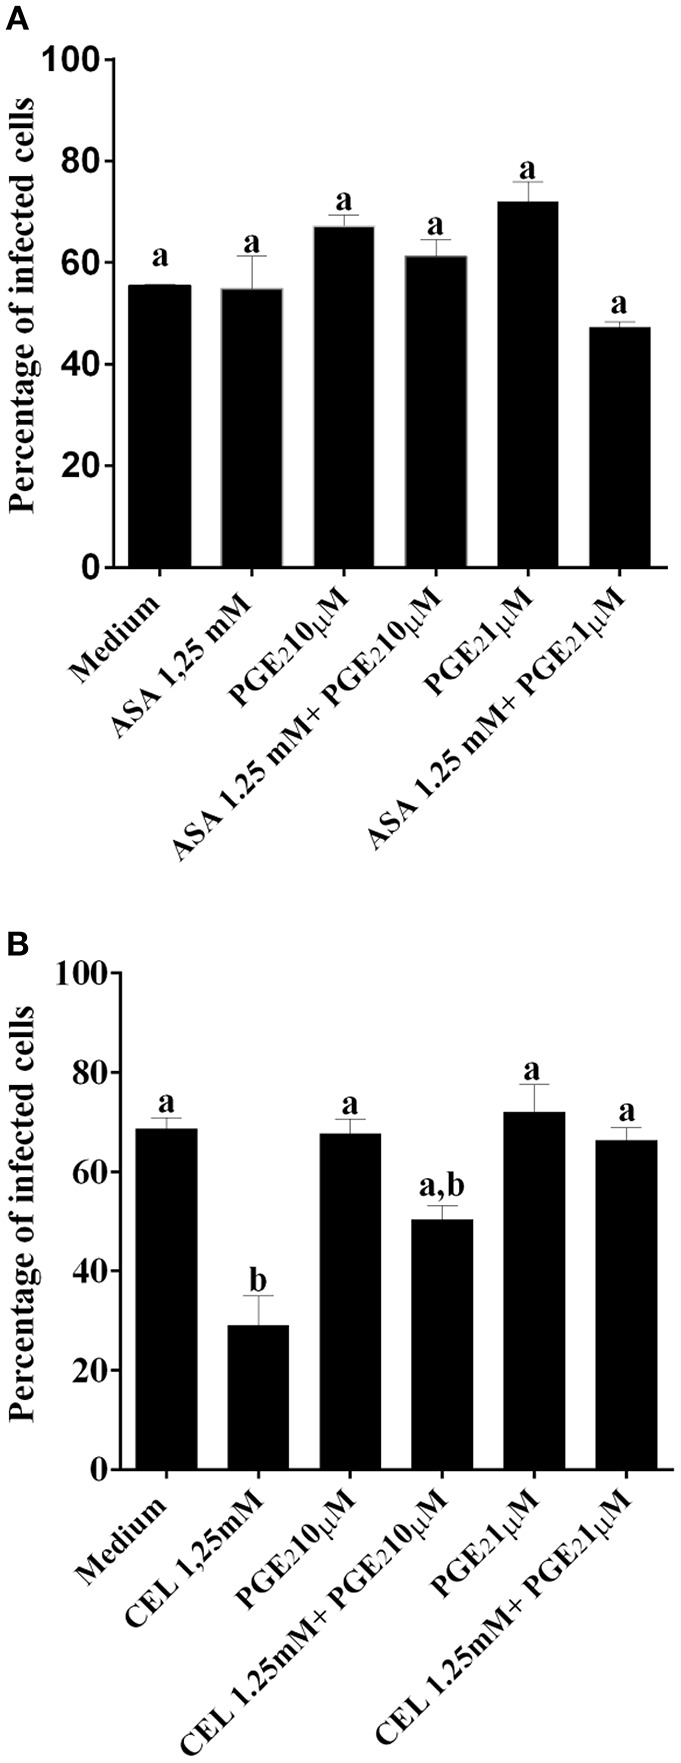
PGE2 restored the invasiveness of T. cruzi in DC-PBMC previously treated with CEL. DC-PBMC were treated for 30 min with separately either with or without PGE2 (1 or 10 μM) alone or in combination with ASA (A) or with CEL (B) and exposed to 5:1 trypomastigotes of T. cruzi (Y strain) during 18 h. After cells were fixed with methanol and stained with Giemsa stain. Results are the mean ± standard error for duplicate determinations, with three blood donors in each experiment. Means not sharing letter are significantly different (P < 0.05, one-way ANOVA with Tukey's post-test).